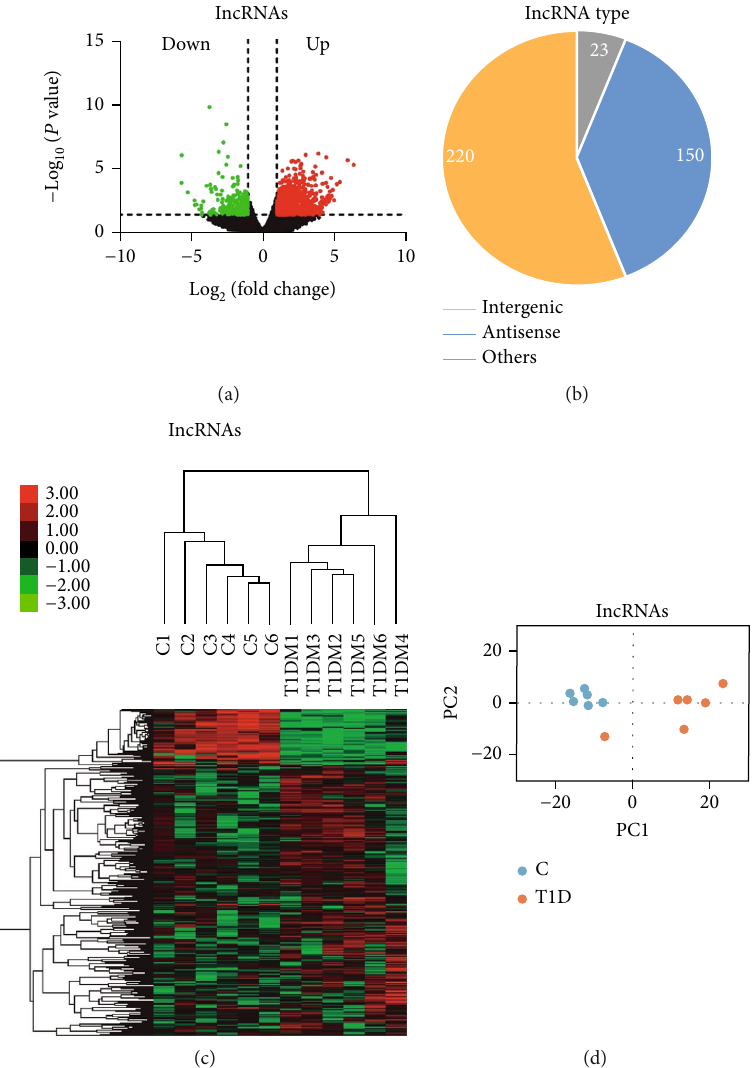
Figure 2: Features of novel lncRNAs in T1D patients as compared with those in healthy controls. (a) Di ff erentially expressed lncRNAs (T1D- lncRNAs) were identi fi ed from a volcano plot showing data from T1D patients relative to healthy controls. The vertical black lines correspond to twofold up- and downregulation, respectively, and the horizontal black line represents a p value of 0.05. The red and green points in the plots represent the di ff erentially expressed transcripts in T1D patients with statistical signi fi cance for upregulation (324 lncRNAs) and downregulation (69 lncRNAs), respectively. (b) Pie chart representations show the proportion of T1D patients associated with lncRNAs that are transcribed as antisense (blue), intergenic (orange), or other types (grey) and analyzed postoptimization. (c) Di ff erential lncRNA expression pro fi les were hierarchically cluster analyzed and shown as a heat map, wherein 393 lncRNAs were upregulated (red) or downregulated (green). (d) Principal component analysis